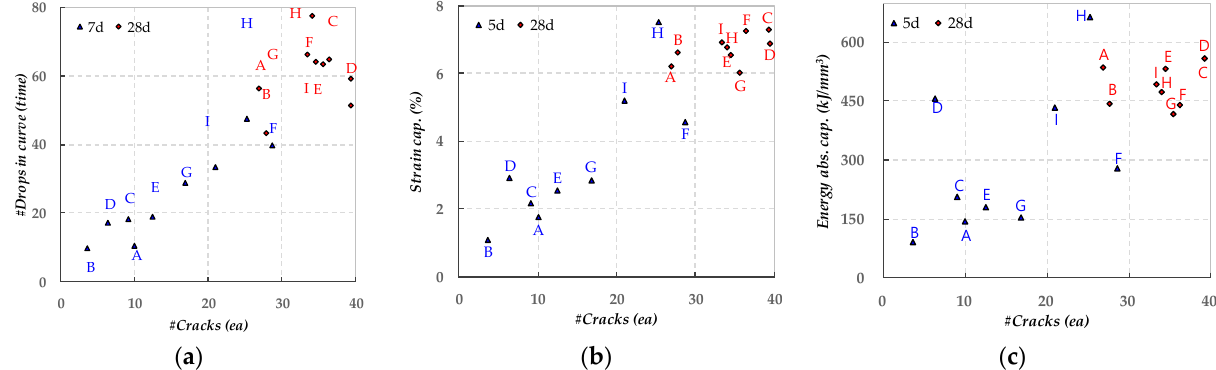
Figure 17. Correlation of #cracks with ( a ) #drops in tensile stress–strain curve; ( b ) strain capacity; and ( c ) and energy absorption capacity. Table 4. Test indexes for tensile and cracking behaviors of UHP–SHCCs.